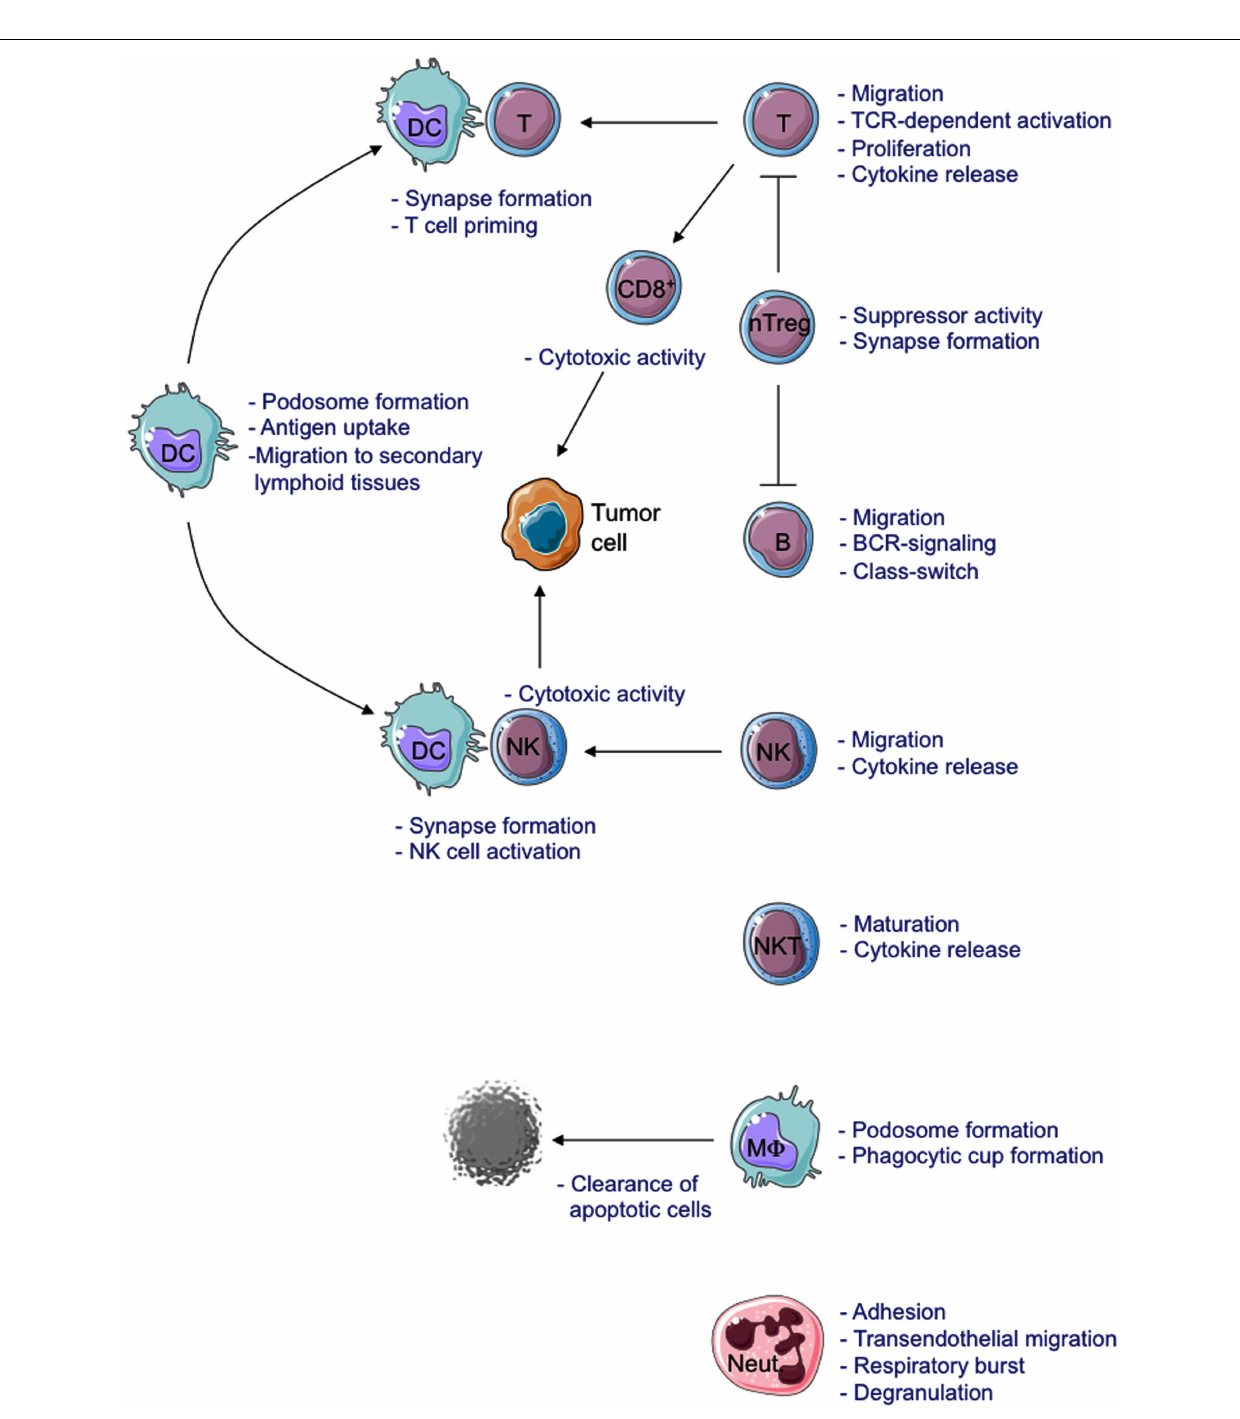
AUTOIMMUNE MANIFESTATIONS IN WAS PATIENTS